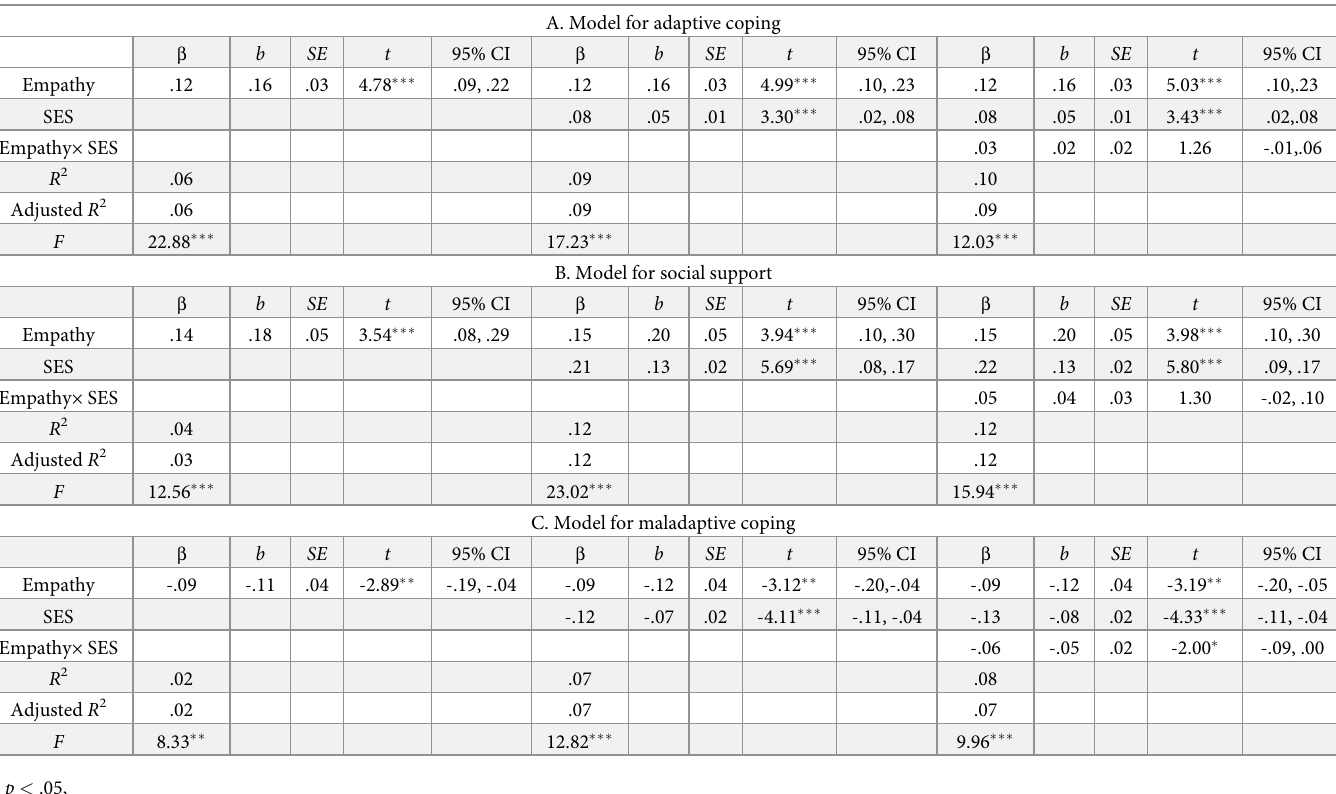
Table 3. Hierarchical regression models predicting coping strategies in Study